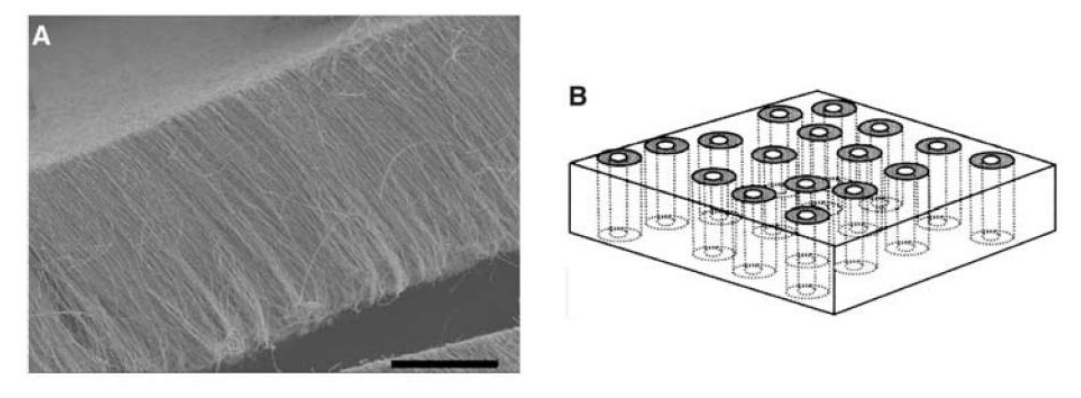
Figure 2. (A) As grown dense multiwalled CNT array from Fe-catalyzed chemical vapor deposition process (Scale bar 50 μm). (B) Schematic of target membrane structure, with a polymer impregnation between CNTs (Hinds et al.,